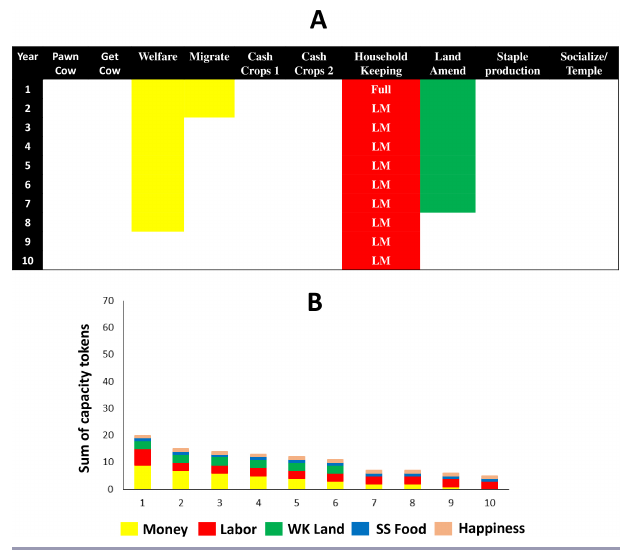
Fig. 10. (A) Simulation of a single-family strategy that results in an outcome in the lower limit of the solution space in The Flow of Peasant Lives. Dice outcomes are assumed to be unfavorable to the household team in every round. This strategy depends on welfare and other government payments, uses minimal labor, and does not pawn the cow (savings). L = labor; M = money. (B) Dynamics of capacity reproduction resulting from the strategy shown in (A). Capacities decrease over time but do not collapse. The horizontal axis shows the sequence of rounds.